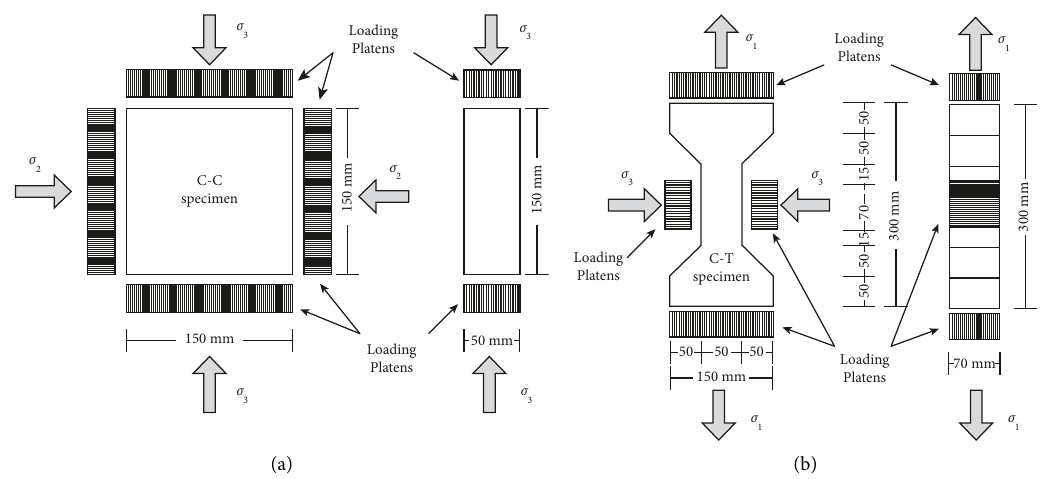
Figure 2: Geometric dimensions of RPC specimens used in the (a) C-C and (b) C-T tests.